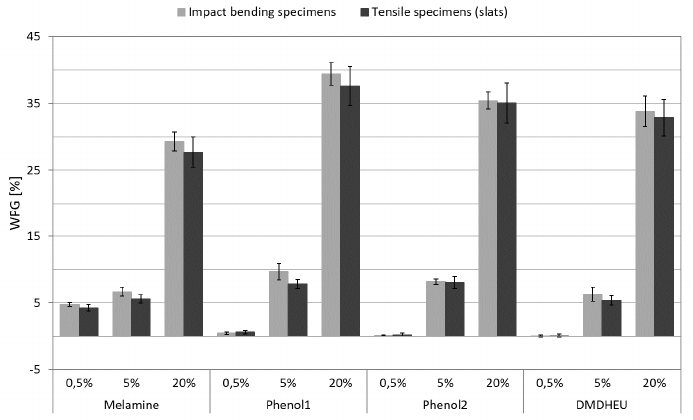
Figure 2. Weight Percent Gain (%) of impact bending and tensile specimens depending on modification agent and concentration (mean and SD).